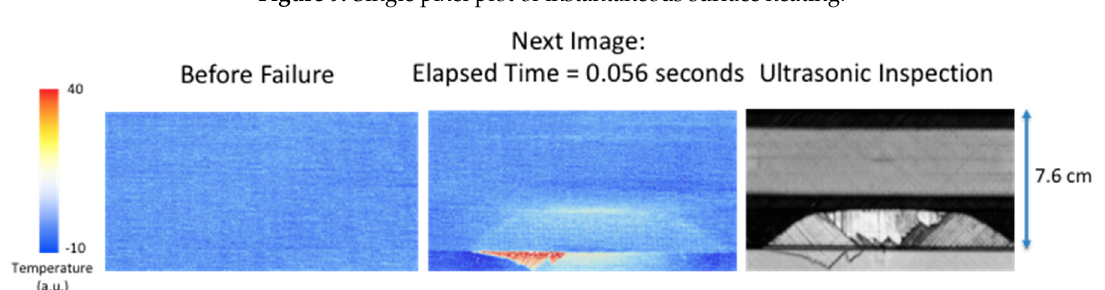
Figure 10. Comparison of large area instantaneous surface heating to ultrasonic inspection.